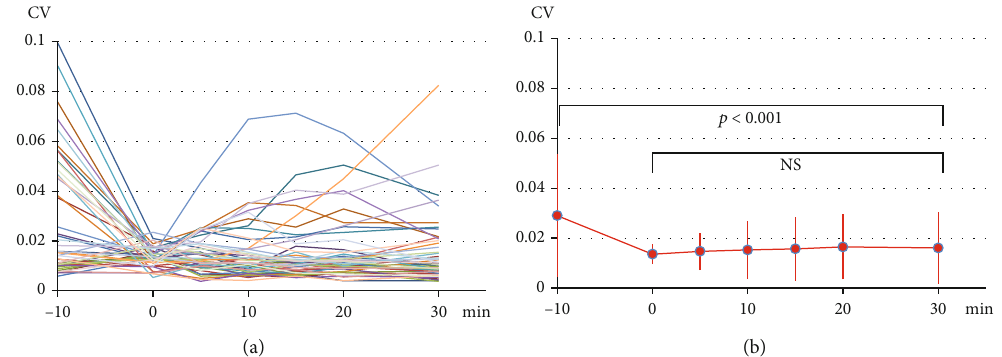
Figure 3: (a) Time-course changes in the mean CV of both hands in 47 patients. The mean of each patient is plotted in a single line. (b) Means and SDs of CVs. CV: coe ffi cient of variation.